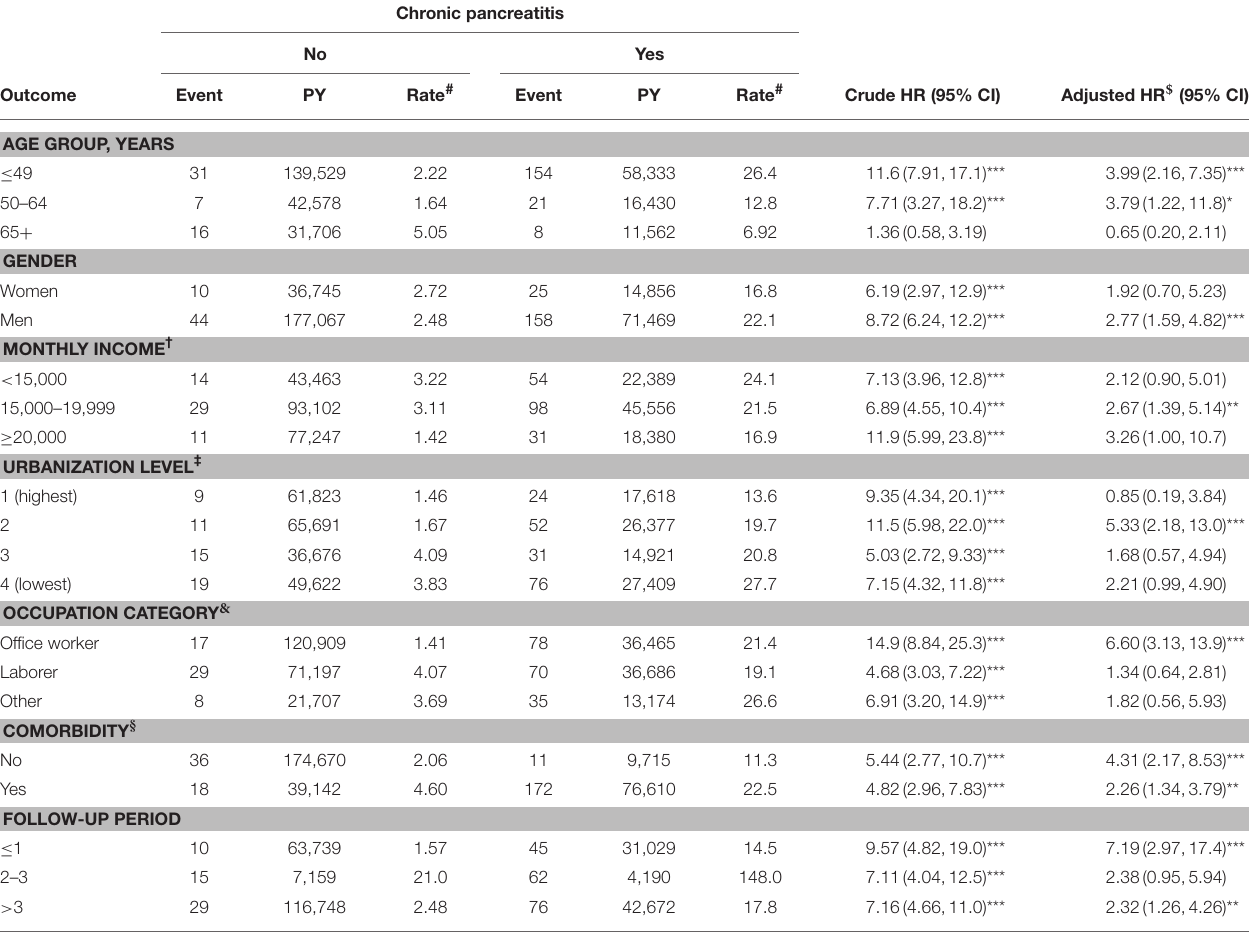
TABLE 3 | Incidence and hazard ratios of suicide attempt for individuals with and without chronic pancreatitis stratified by demographics and